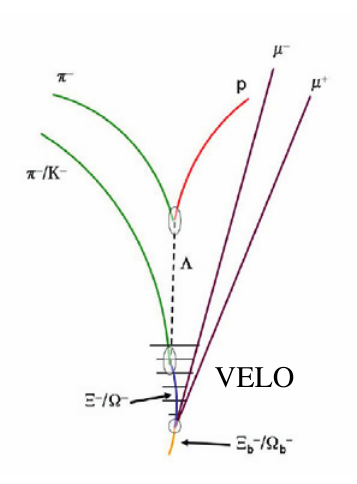
Figure 10. Scheme of the Ξ − b ( Ω − b ) decay. In this particular example two decay vertices are located inside the VELO while the Λ vertex is located outside due to its long lifetime.